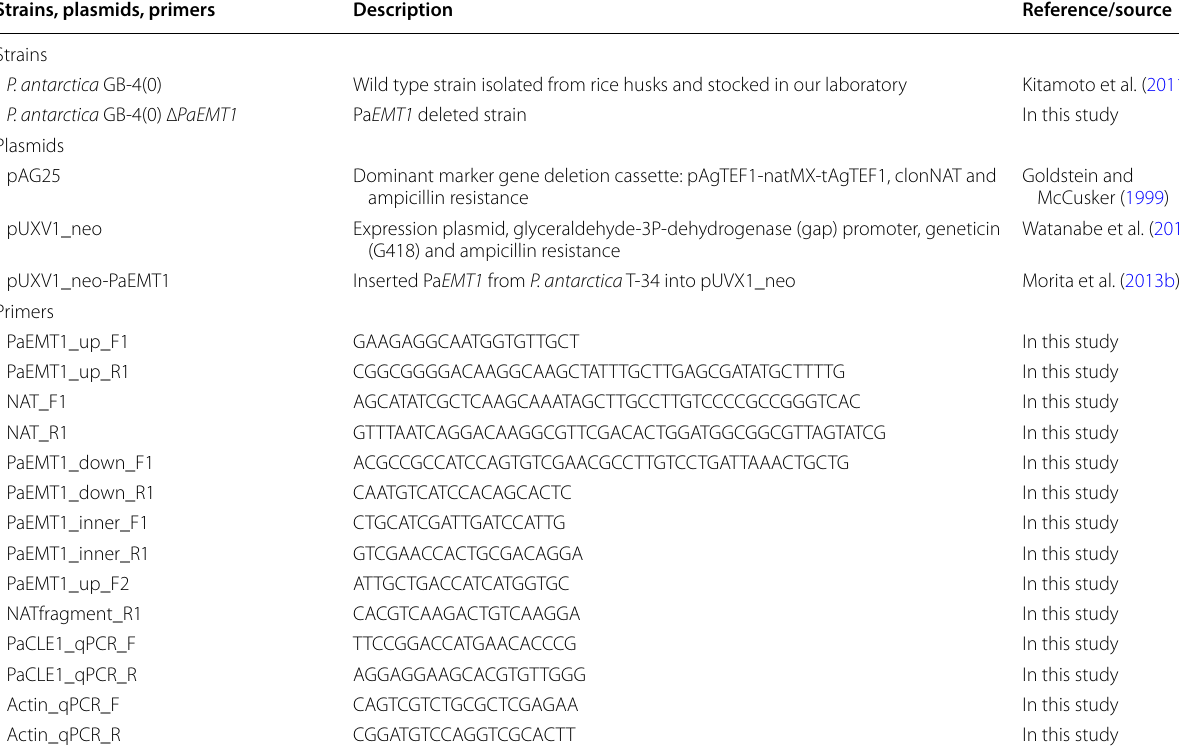
Table 1 Strains, plasmids and primers used in this study Strains, plasmids, primers